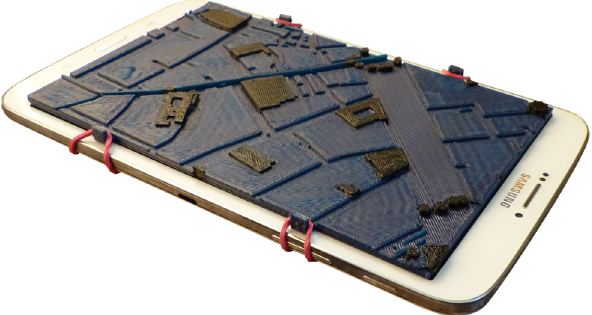
Figure 4. A tactile map attached to a tablet using rubber bands (interactive map symbols in black).